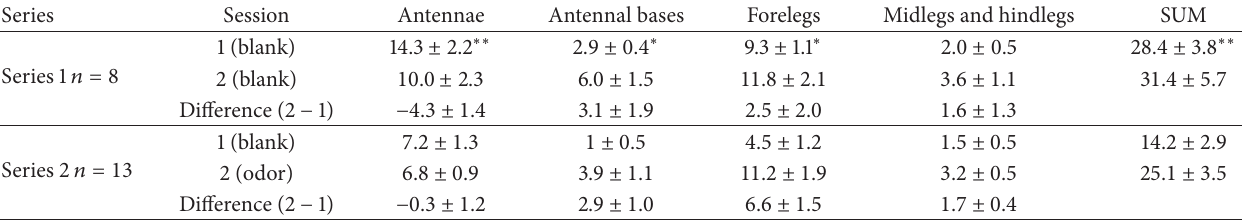
Table 2: The number of observed grooming events (count). Mean ± Standard error. Difference was calculated for each animal.